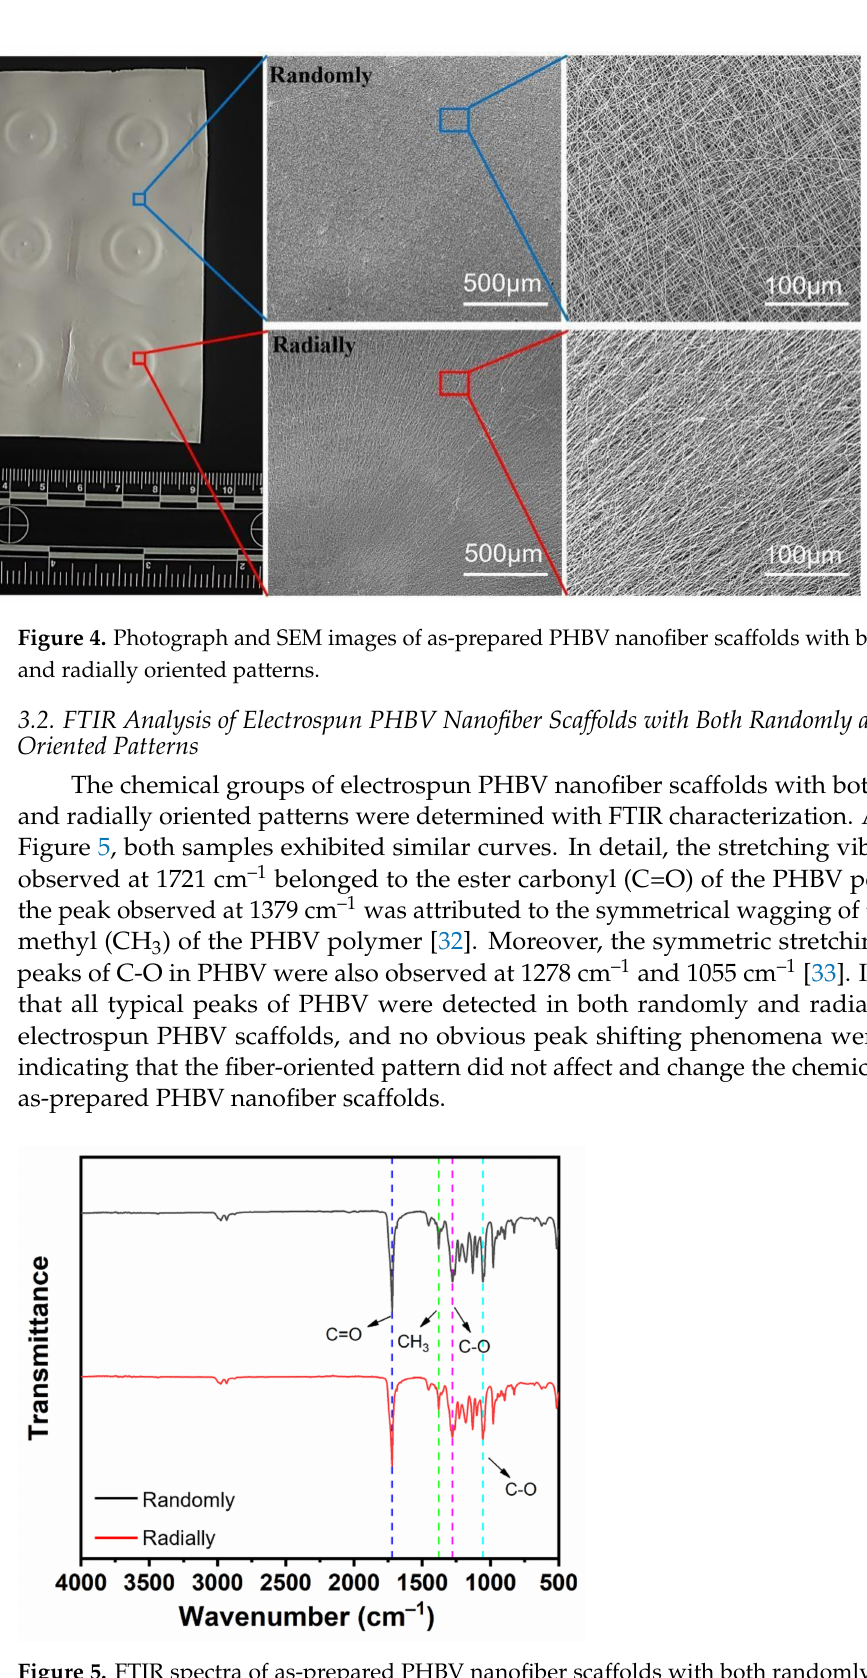
Figure 5. FTIR spectra of as-prepared PHBV nanofiber scaffolds with both randomly and radially oriented